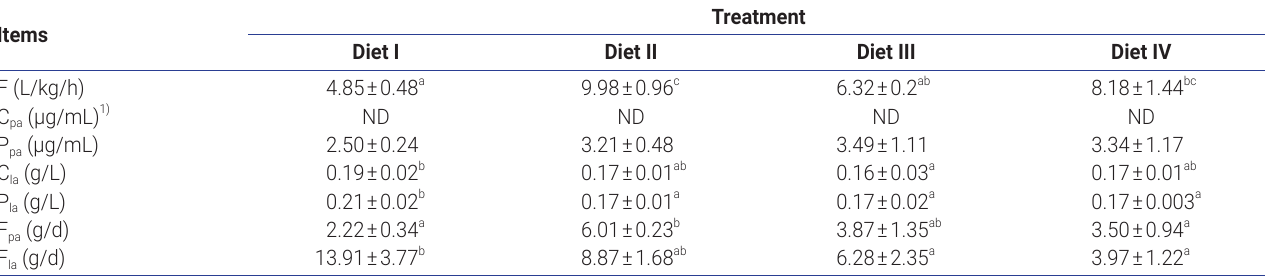
Table 4. Lactic acid and propionic acid net absorption in the portal vein of weaned piglets in Exp 1